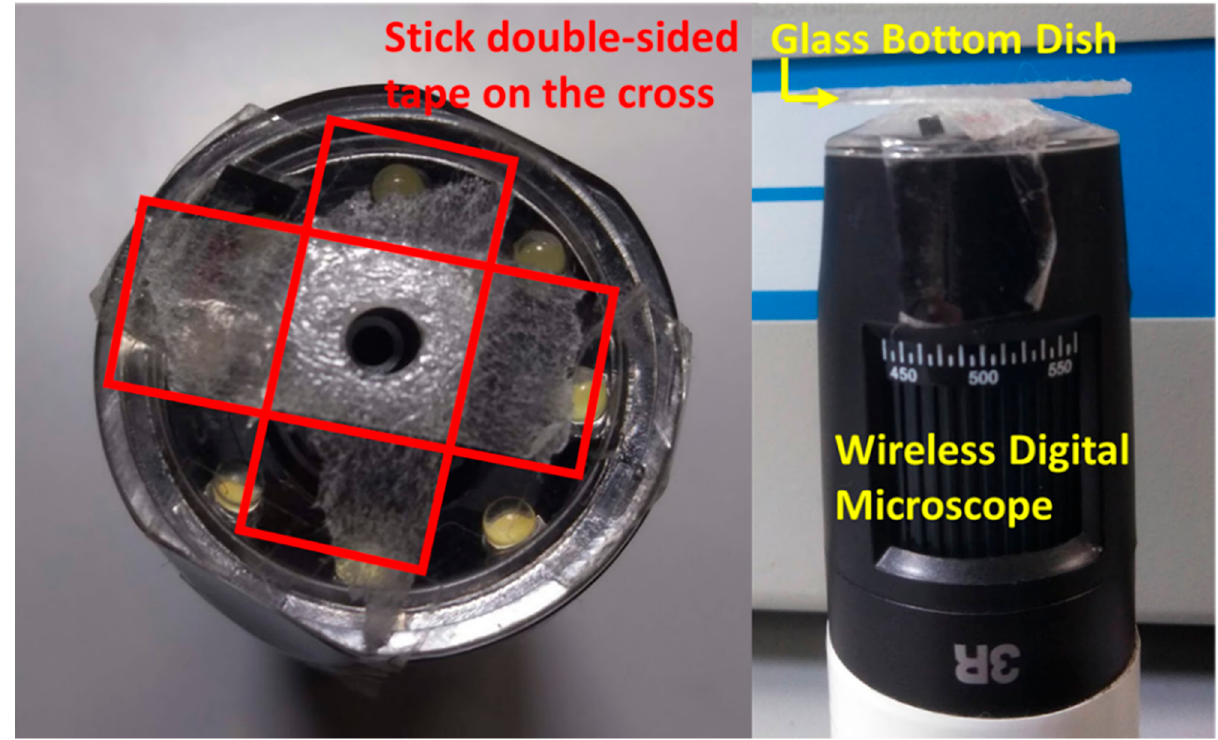
Figure 4. Glass bottom dish and microscope setup.